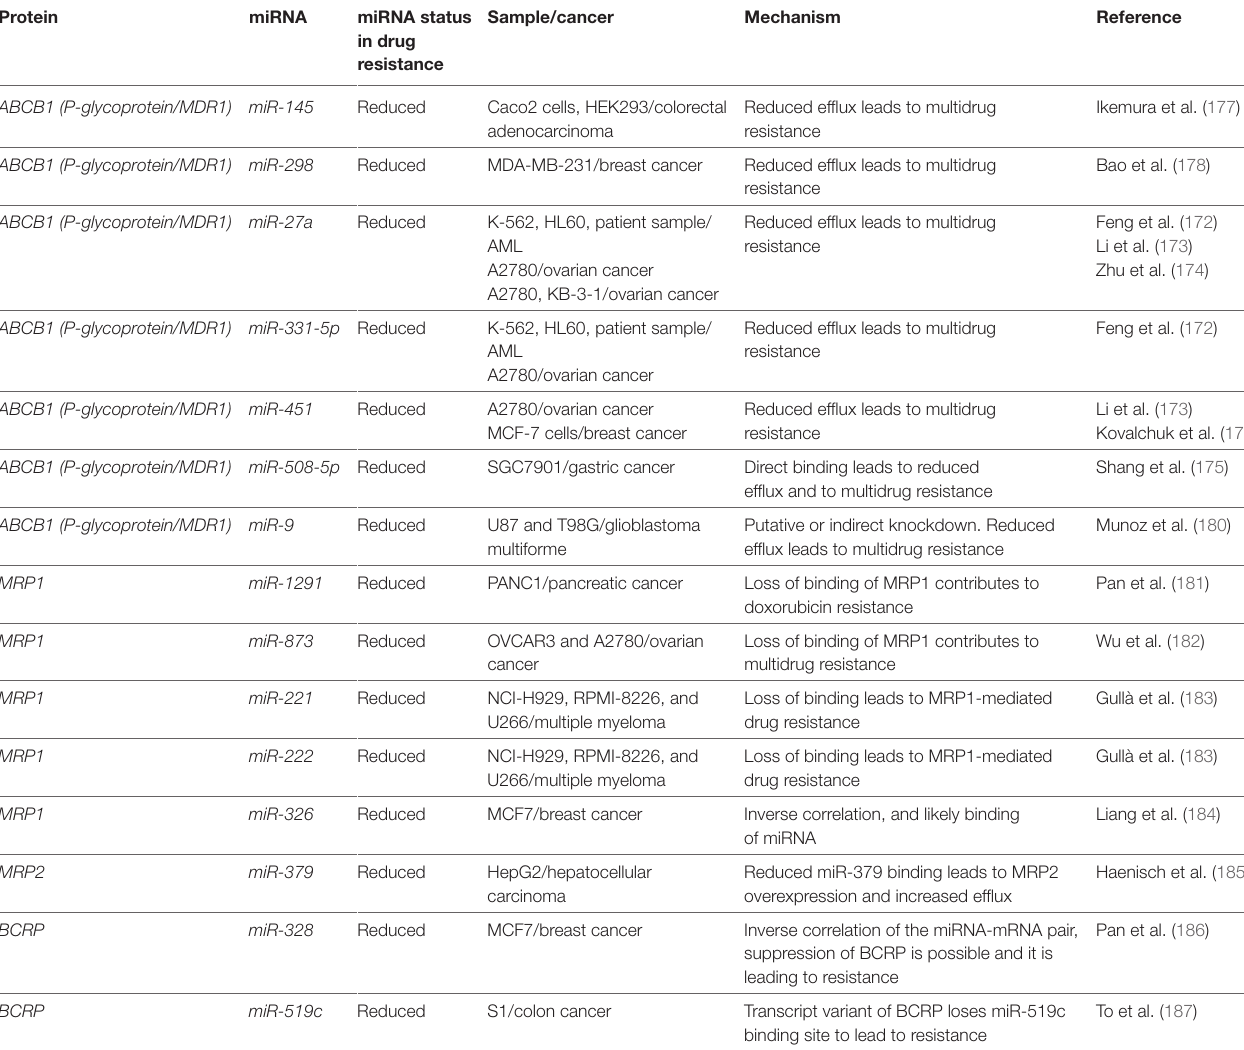
TABLe 5 | Drug trafficking gene disinhibitions caused by loss of miRNAs can lead to drug resistance.